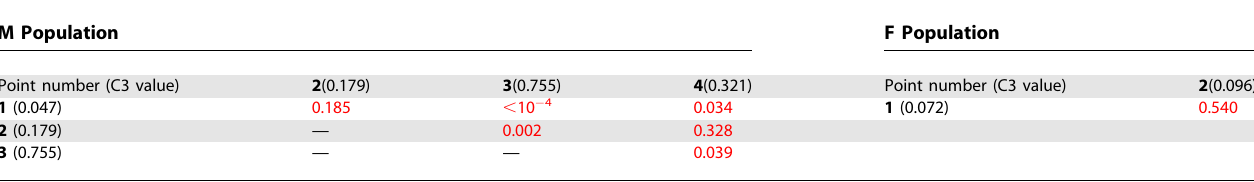
C3 values at evenly spaced positions (numbered from 1 to 4 on the M plot, 1 and 2 on the F plot) along each plot (green dots in Figure 6) were compared using a simulation-based approach (see Materials and Methods). For each pair-wise comparison, p -values (in red) given in the table correspond to the H 0 hypothesis that the intensity of interference is actually the same at both positions. For each point (in bold), C3 value is indicated between parentheses.